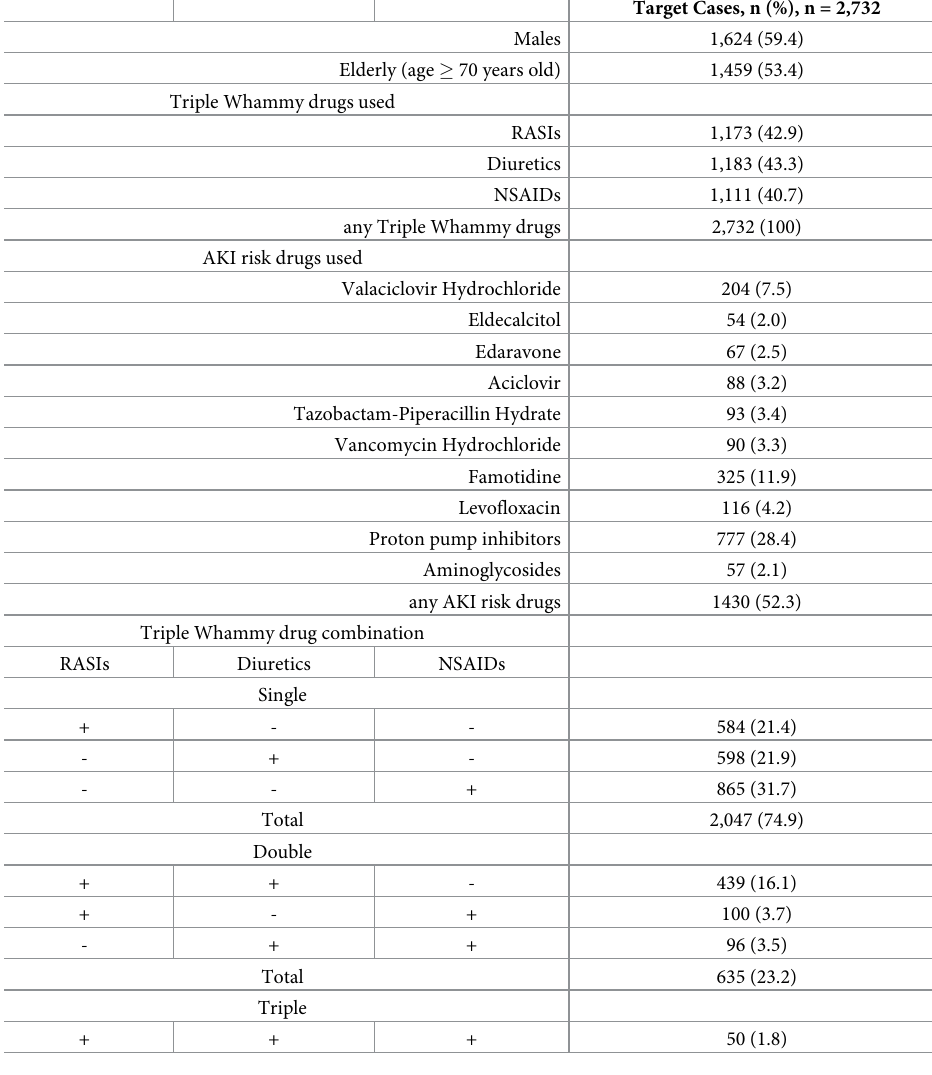
Table 2. The characteristics and TW drug combinations in target